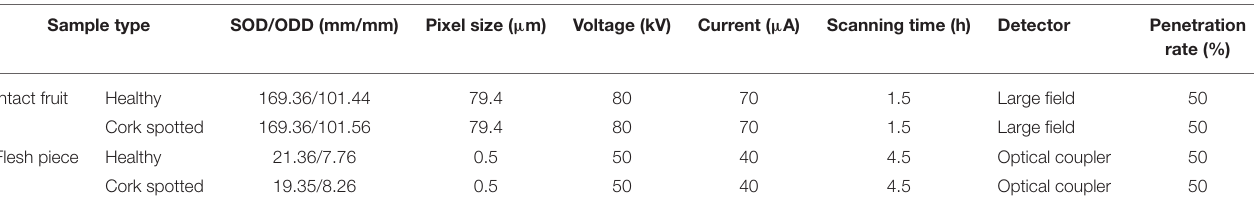
TABLE 1 | Settings of X-ray scanning used in this study. Sample